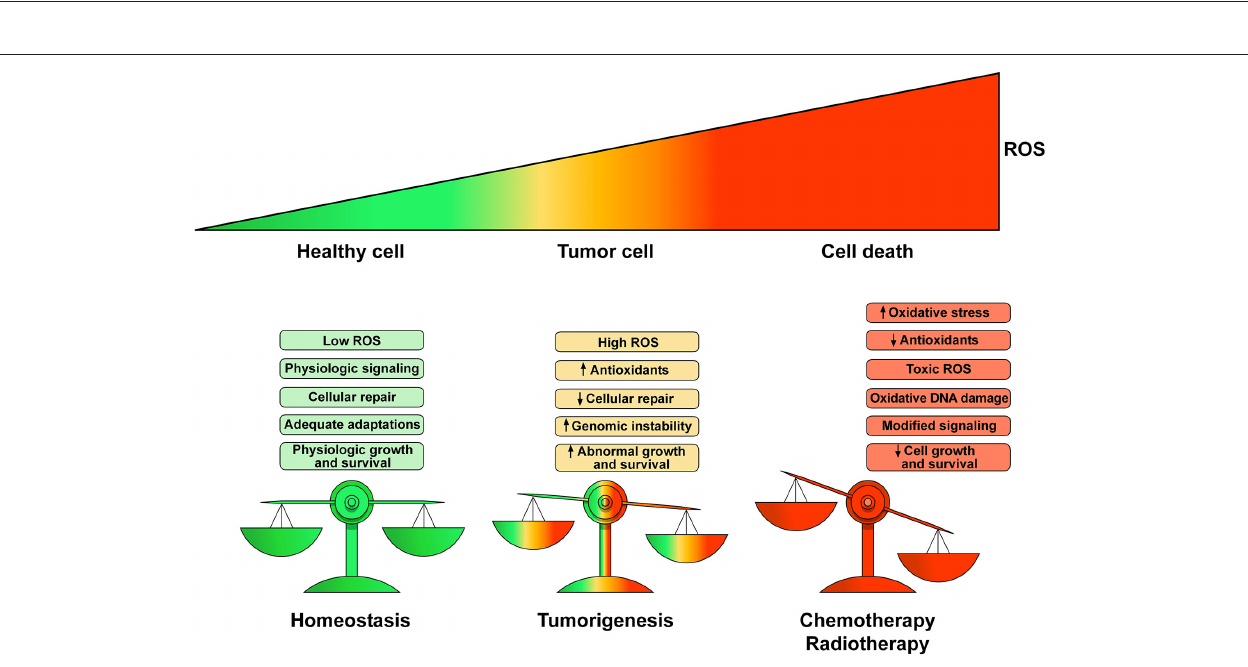
FIGURE 2 | Schematic representation of the homeostatic role of ROS and their pathologic role in tumor growth and cell death. Low production of ROS and balanced antioxidant activity play a fundamental role in cellular signaling and repair resulting in controlled growth and survival. Proliferation of tumor cells yields elevated ROS concentrations enhancing cell survival and proliferation leading to DNA damage and genetic instability causing cell dysfunction. Chemotherapeutic agents and radiotherapy increase ROS production to toxic concentrations resulting in irreparable damage to the cell, inadequate adaptations and eventually cell death. The heart is particularly vulnerable to ROS/RNS injury because antioxidant resources are lower than other tissues. Modified with permission from Moloney and Cotter (2017).